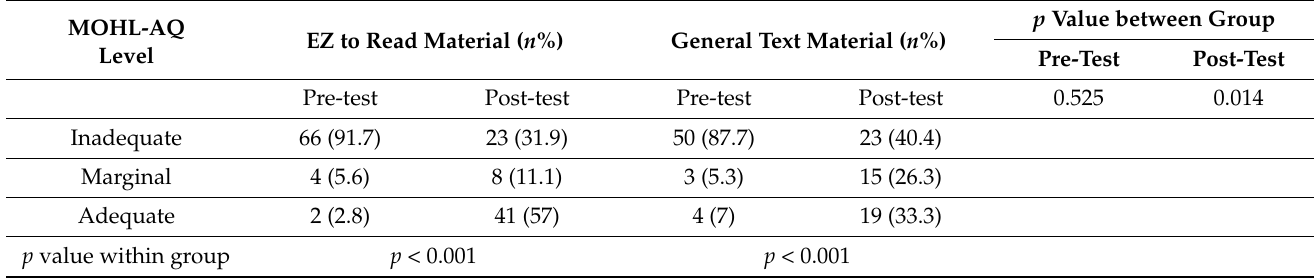
Table 5. The difference between pre-test and post-test of MOHL-AQ levels within and between groups.